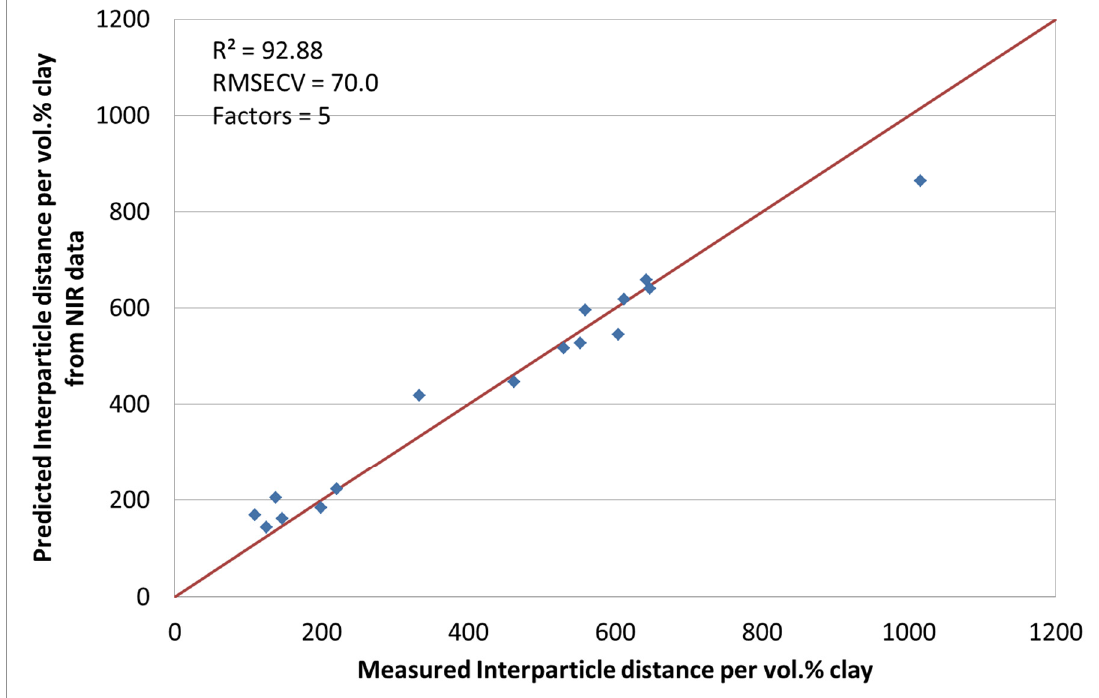
Figure 6. Predicted interparticle distance per vol. % clay values by NIR versus measured.